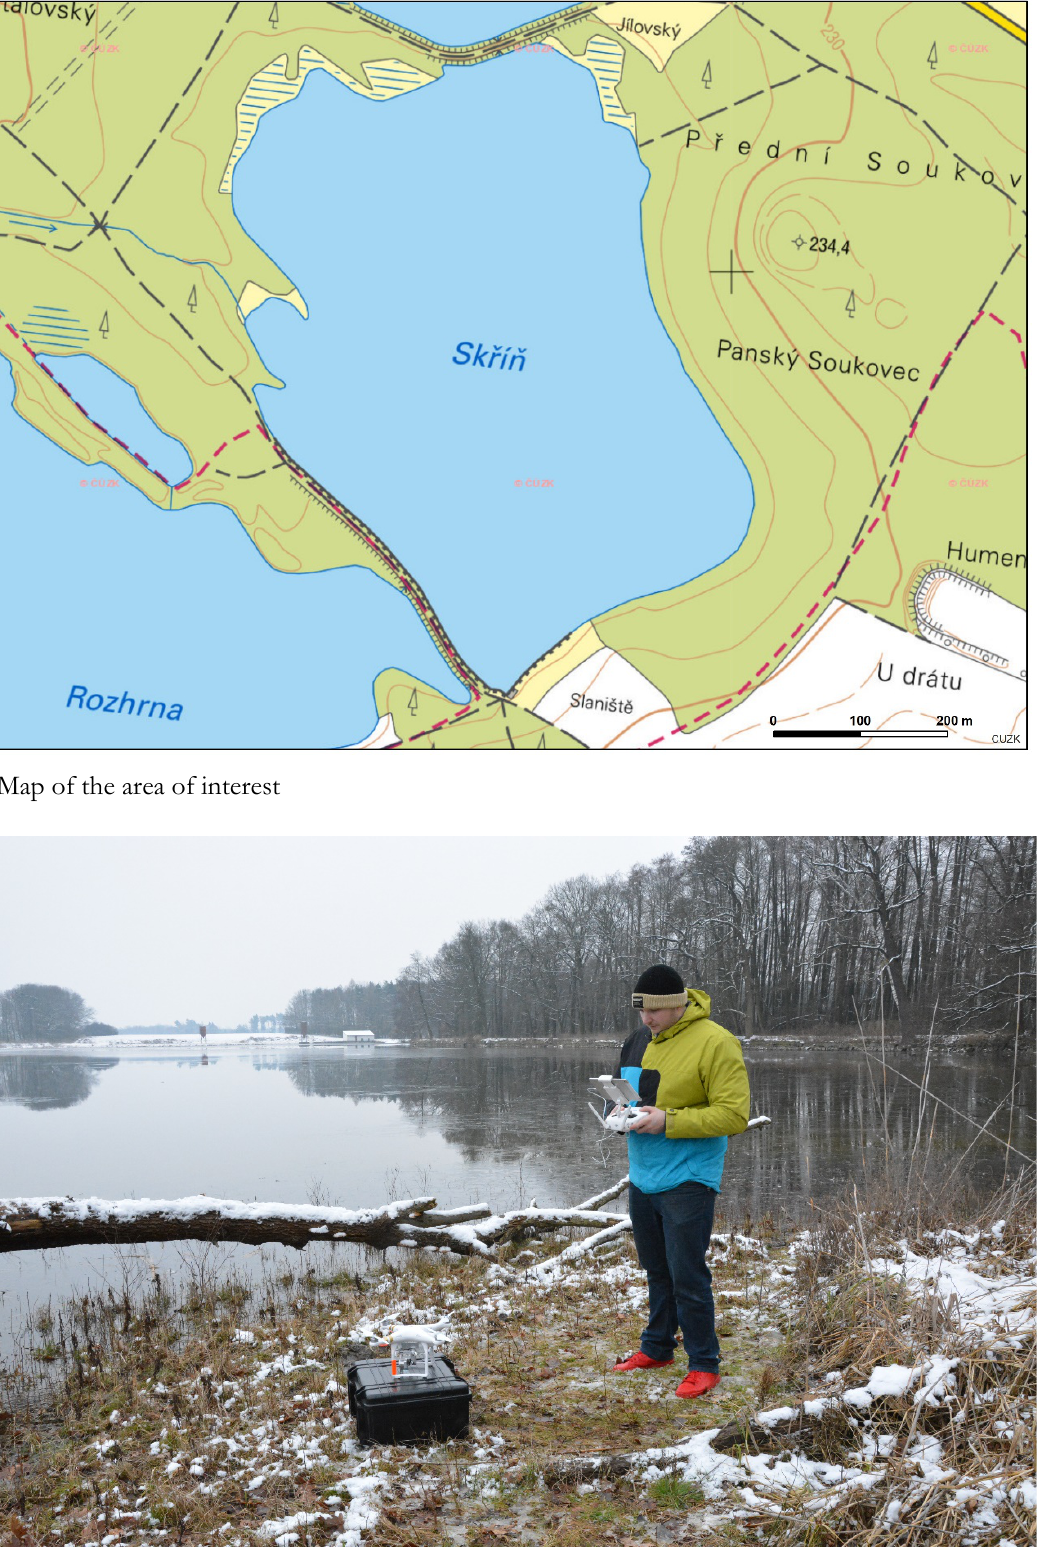
Figure 2. Phantom 3 on the shore of the area of interest before the flight (February